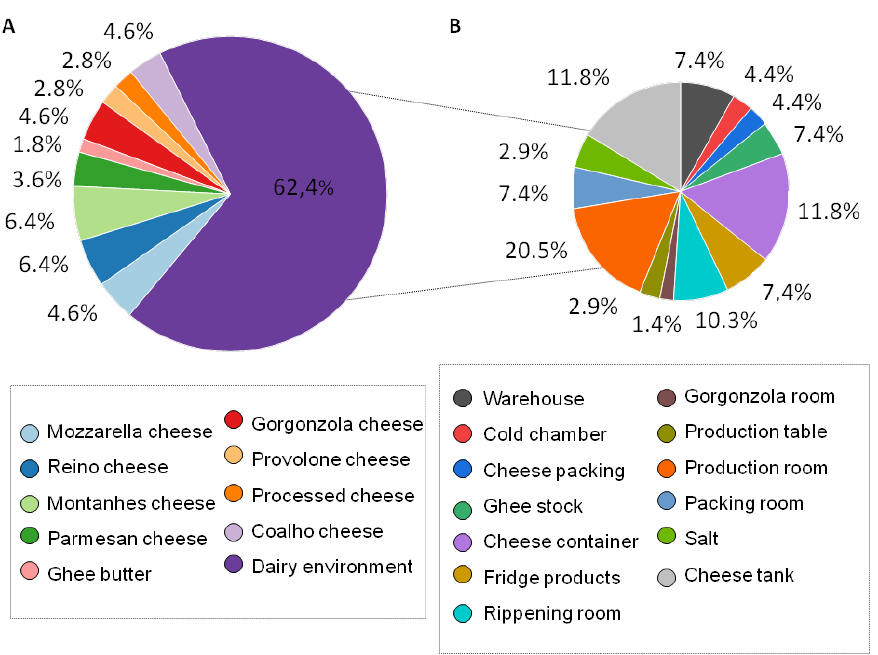
Figure 1. Percentage of filamentous fungi isolated from spoiled dairy products ( A ) and dairy processing environment, equipment, and tools ( B ).